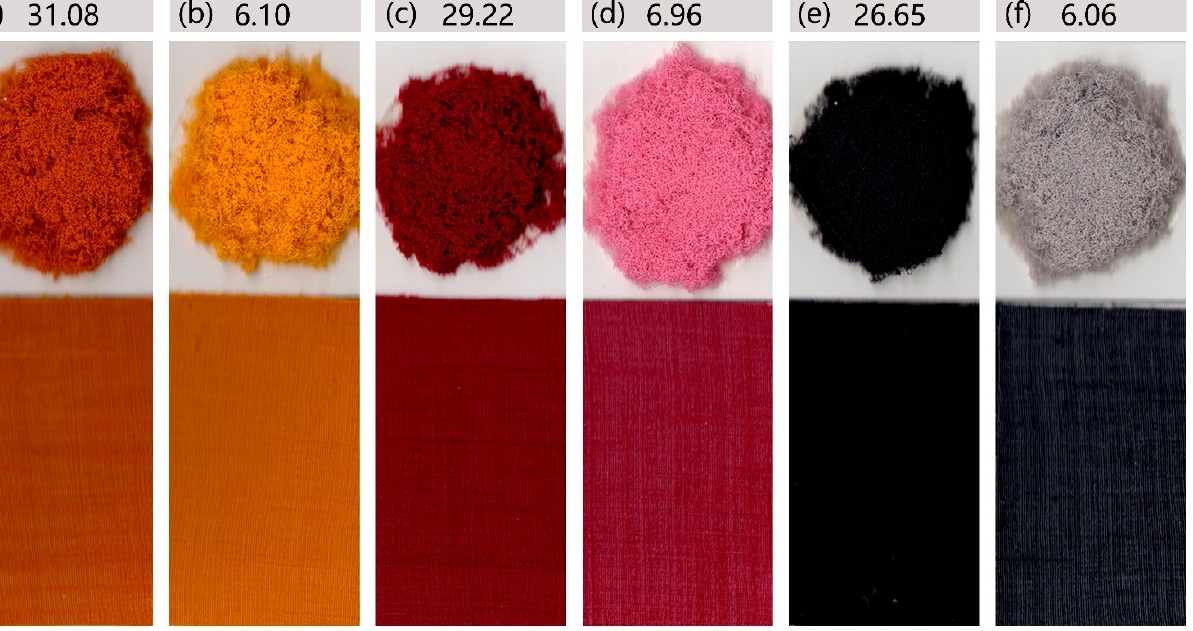
Figure 2. Comparison of dyeing properties between dyeable spandex and ordinary spandex: ( a , c , e ): dyeable spandex and fabric woven from dyeable spandex and Nylon 6 dyed with yellow, red, and black dyestuffs, respectively; ( b , d , f ): ordinary spandex and fabric woven from ordinary spandex and Nylon 6 dyed with yellow, red, and black dyestuffs,